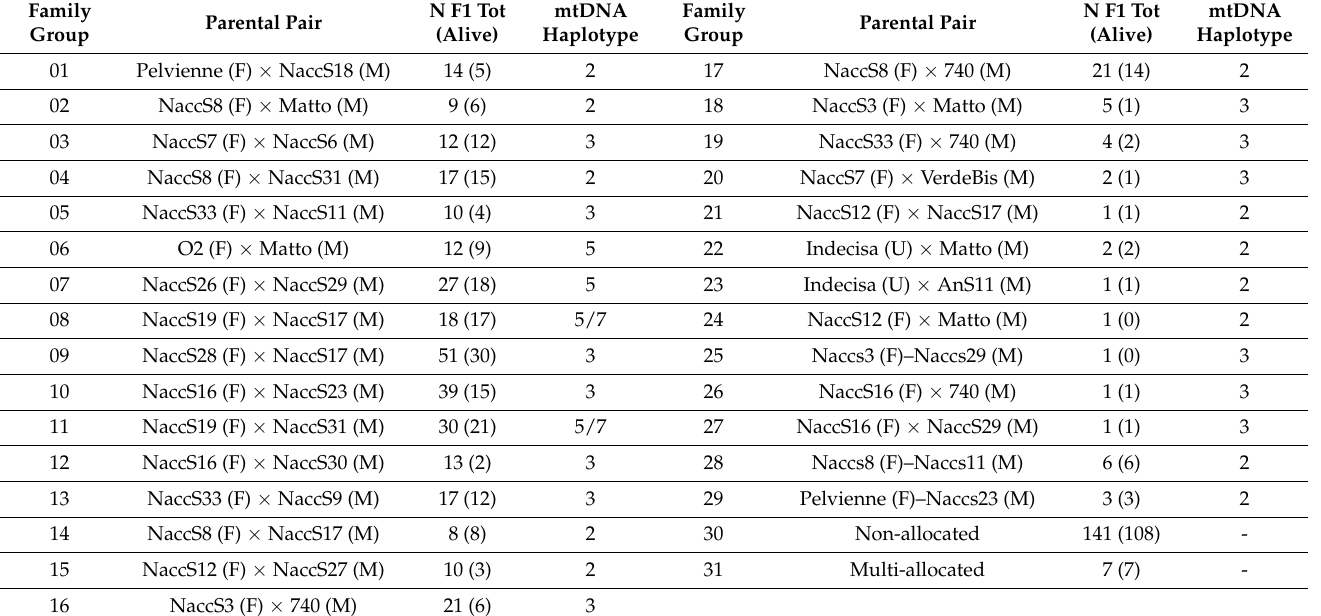
Table 1. Resum é of family groups identified with parental allocation analysis based on 15 microsatel- lite loci. For each family group, the parent pair, the total number of allocated animals, and the number of survived ones (in brackets) are reported as well as the maternal mitochondrial haplotype. The families 08 and 11 are composed of F1 animals carrying the mitochondrial haplotypes 5 or 7, and in some cases, animals showed heteroplasmy with both the mitochondrial variants. This was due to the heteroplasmic condition of the shared F0 female. Further details for each individual analyzed are reported in Table